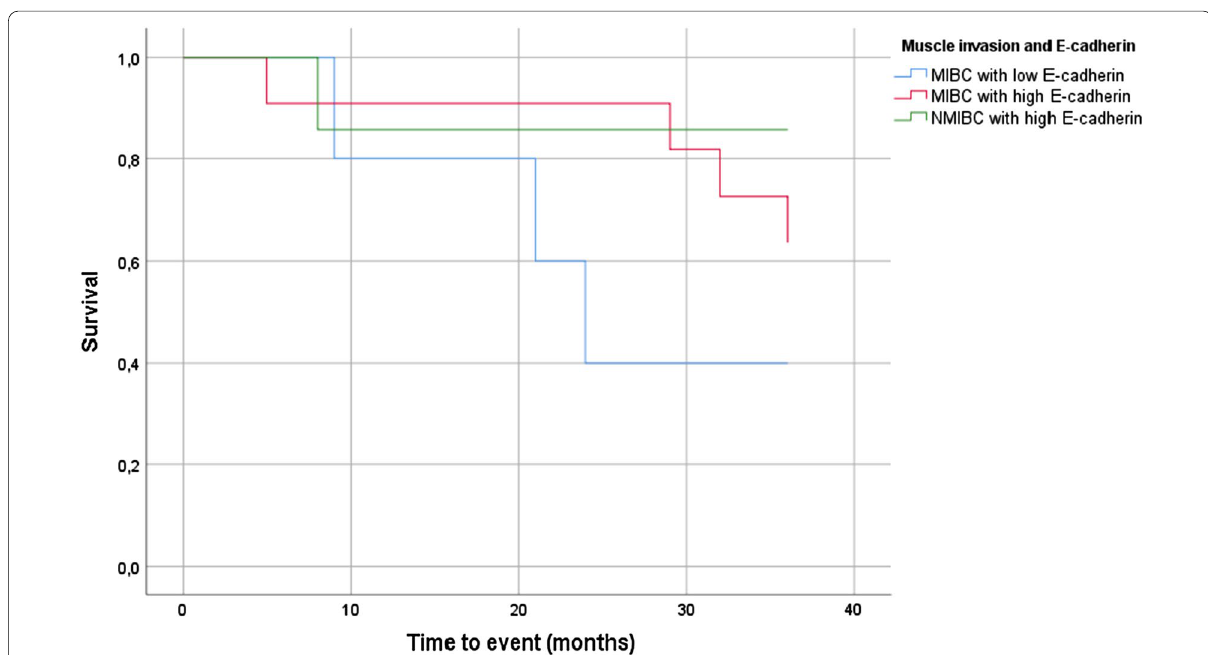
Fig. 2 Three-year survival rate of subjects based on muscle invasion and E-cadherin expression with log rank-test ( p